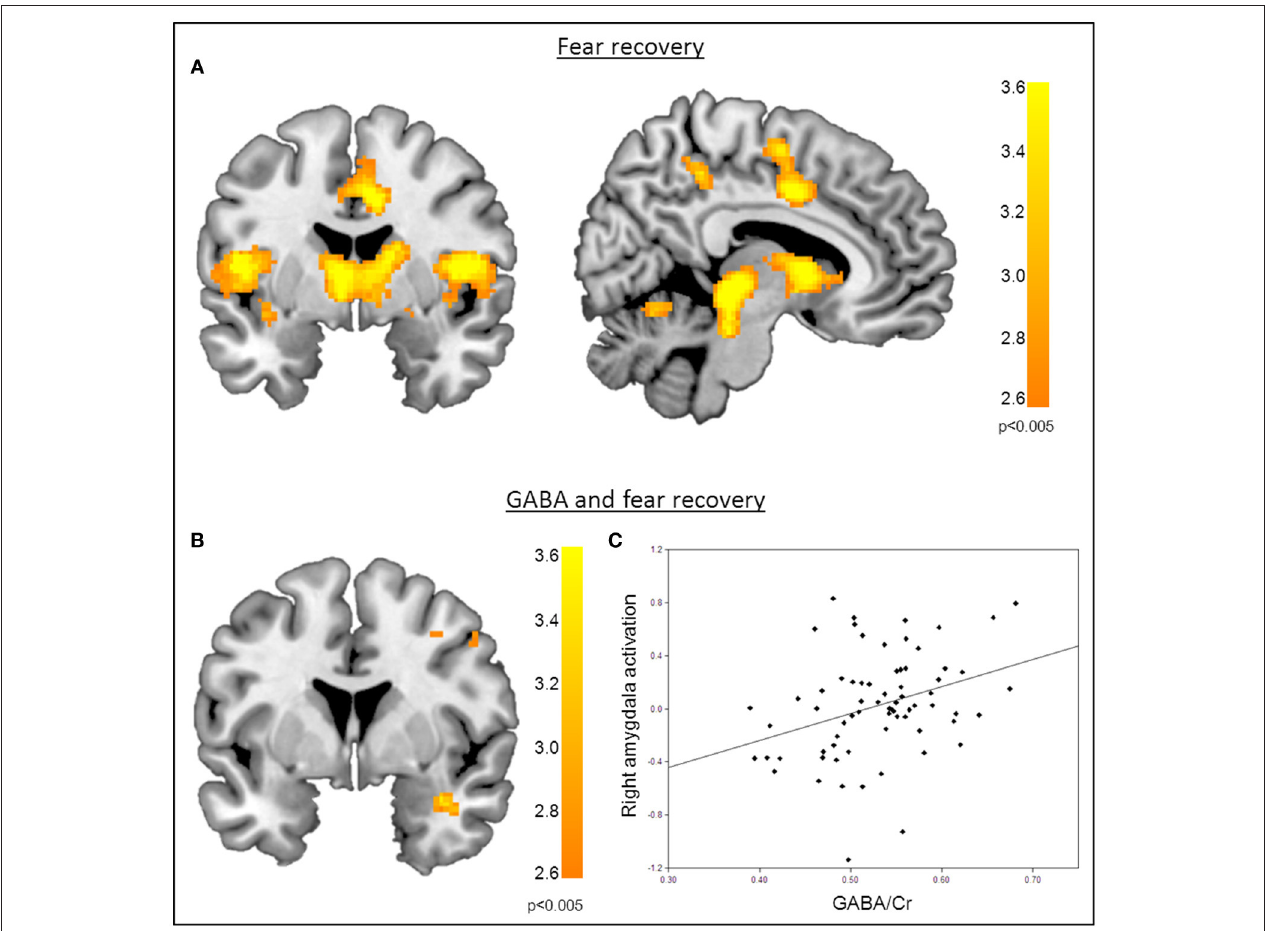
FIGURE 3 | Correlation of GABA levels and BOLD activity during fear recovery. (A) Increased BOLD activity in the middle cingulate gyrus, the thalamus, the right putamen, and the supramarginal gyrus during fear recovery. (B) Voxel-wise correlation of GABA and right amygdala activation during fear recovery, showing that high GABA levels are associated with increased activation of the right amygdala (MNI x,y,z = 36, 2, − 24; P SVC < 0.05). Threshold for displaying the images is set at P = 0.005, uncorrected. (C) Correlation between GABA concentrations and BOLD signal changes extracted from the right amygdala during fear recovery for illustration purposes, indicating that high GABA levels lead to increased fear recovery while low GABA levels are associated with a decrease in fear